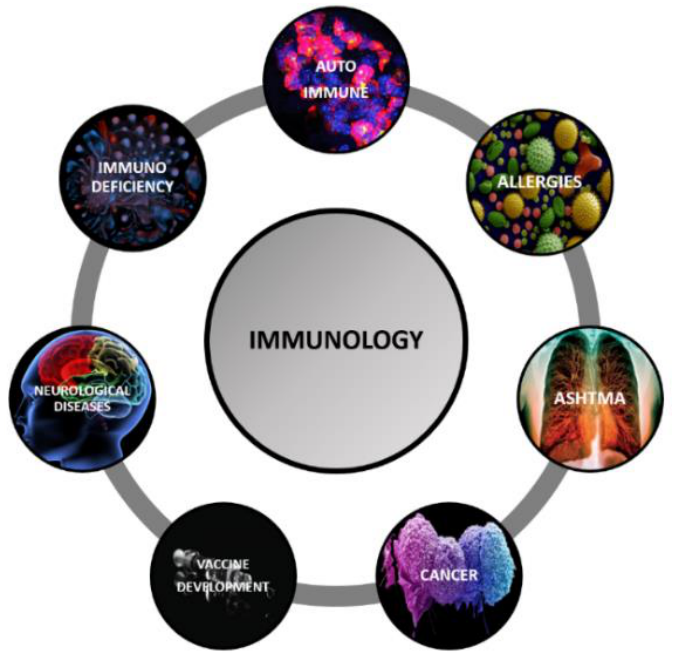
Figure 11. The representation of subdomains of immunology.